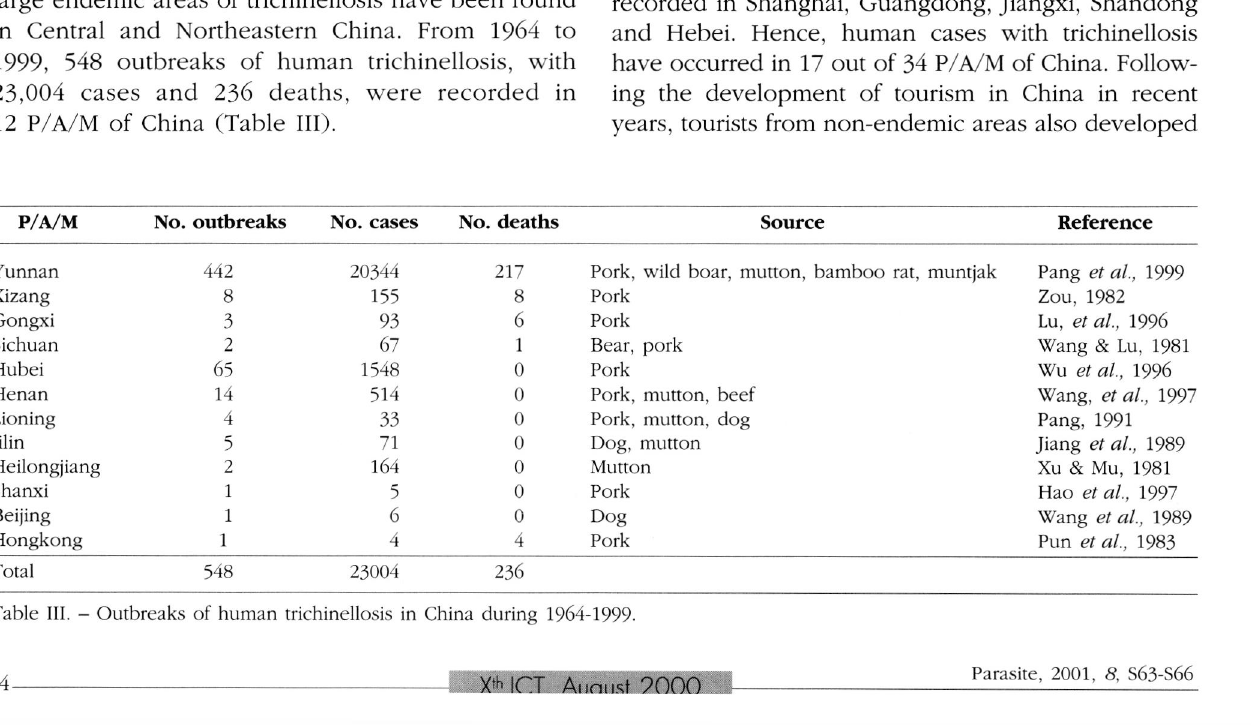
break in China occurred in the same province in